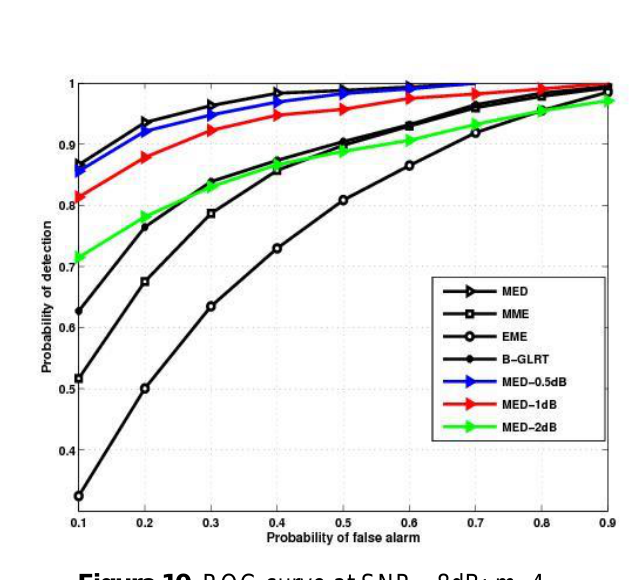
Figure 10. ROC curve at SNR=-8dB: m=4,